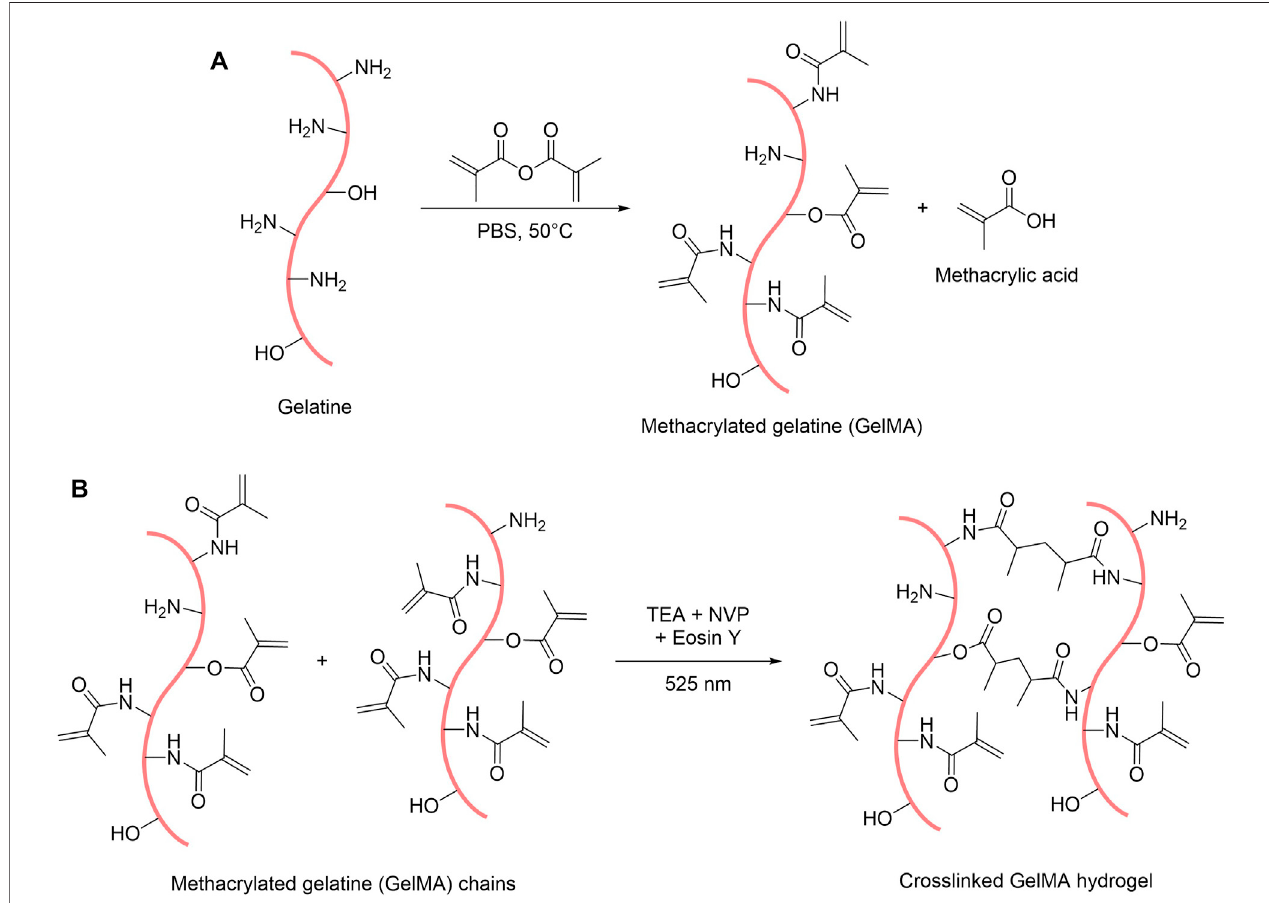
FIGURE 1 | Scheme of the reactions for the synthesis of GelMA (A) and for the formation of GelMA hydrogels (B) .